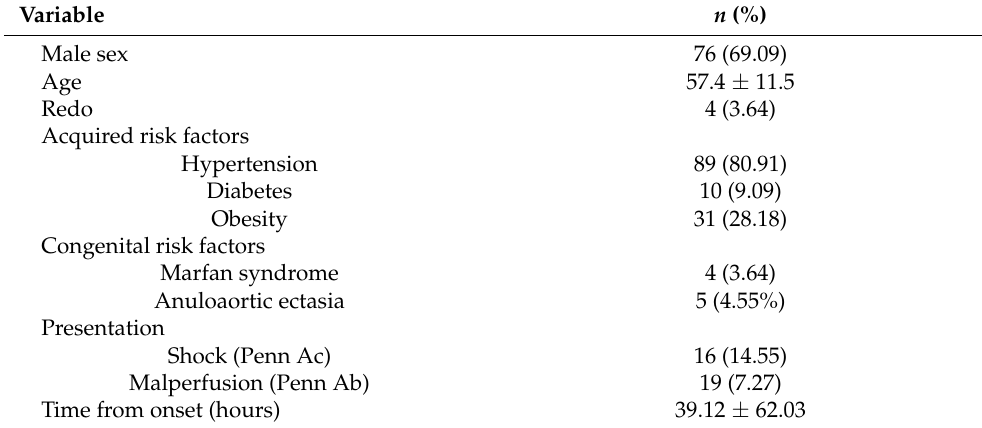
Table 1. Patient